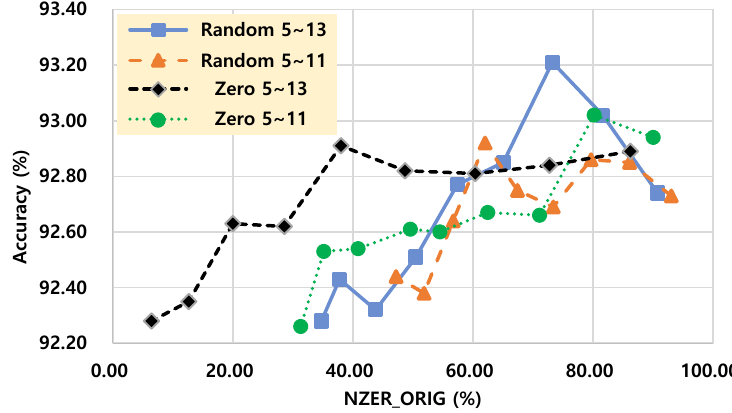
Figure 5. Non zero element rate versus accuracy trade-off comparison on VGG-16.